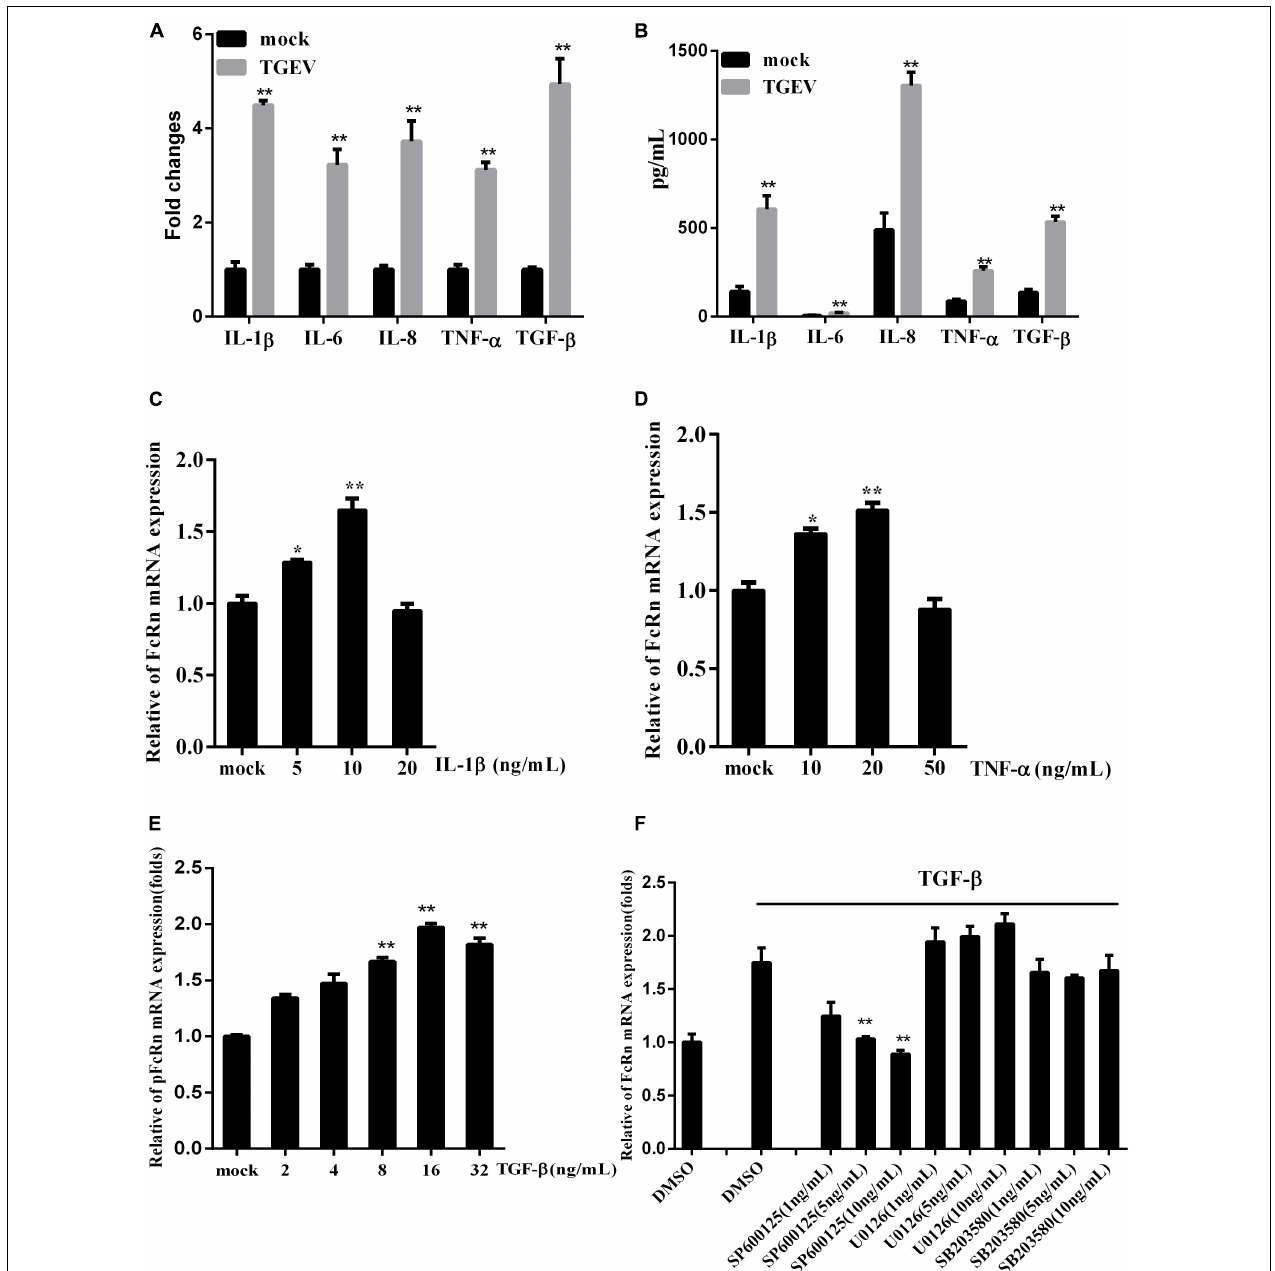
FIGURE 3 | Regulation of FcRn mRNA on IPEC-J2 cells stimulated by TGF- β . (A,B) The relative mRNA and protein levels of IL-1 β , IL-6, IL-8, TNF- α , and TGF- β in IPEC-J2 infected with TGEV for 36 hpi by RT-PCR and porcine cytokine array. (C–E) IPEC-J2 cells were stimulated with TNF- α , IL-1 β , TGF- β for 2 h, and the levels of FcRn mRNA were detected using RT-qPCR. (F) IPEC-J2 cells were pretreated with SB202190 (1, 5, and 10 ng/mL), SP600125 (1, 5, and 10 ng/mL), or U0126 (1, 5, and 10 ng/mL) or DMSO (control) for 2 h, followed by with/without TGF- β for 2 h and the levels of FcRn mRNA were detected using RT-qPCR. ∗ p < 0.05, ∗∗ p < 0.01.